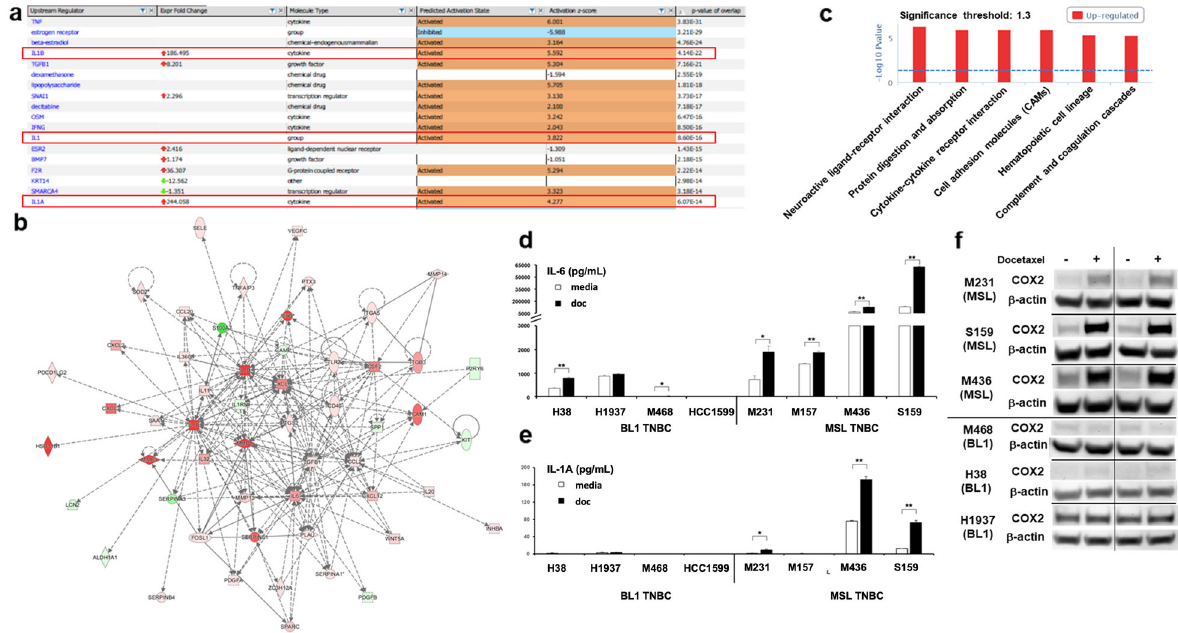
Fig. 1 MSL TNBCs have predicted IL-1A mediated signaling, which is absent in BL1 TNBCs. Four MSL TNBC and four BL1 TNBC cell lines were treated in presence or absence of docetaxel (4 ng/ml) for 48 h and RNA sequencing was performed. a IPA upstream regulator analysis of fold change ratio (cutoff value of 5 or − 5) comparing averaged RPKM from four docetaxel-treated MSL TNBC to averaged RPKM from four docetaxel-treated BL1 TNBC. b IPA pathway builder of IL1A upstream regulator network overlayed with dataset from a (fold change ratio comparing averaged MSL docetaxel treated to averaged BL1 docetaxel-treated samples). c InnateDB analysis of aggregate 16 samples (four MSL media, four BL1 media, four MSL doc and four BL1 doc) with a permutation test comparing MSL to BL1 ( p -value < 0.05 and log2FC > 4). Shown are pathways upregulated in MSL TNBCs compared to BL1 TNBCs. d IL-6 and e IL-1A average ± SEM ELISA results from supernatants collected 48 h from each indicated human TNBC cell lines treated in presence or absence of docetaxel at 4 ng/ml. Each cell line was